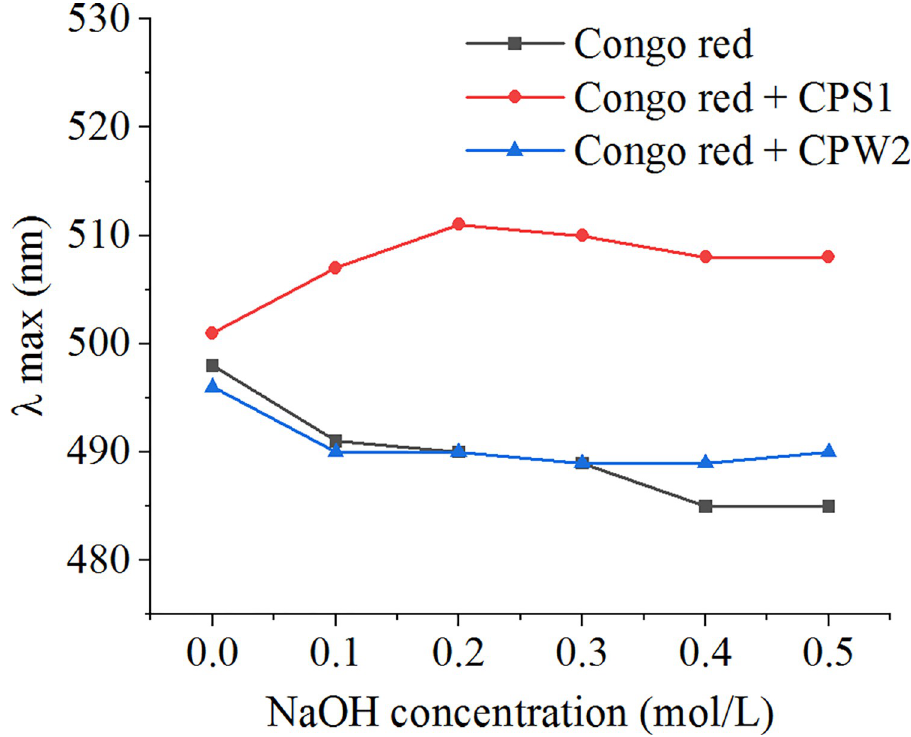
Fig 6. The maximum absorption wavelengths of Congo red-polysaccharide (CPS1 or CPW2) complex at various concentrations of NaOH.